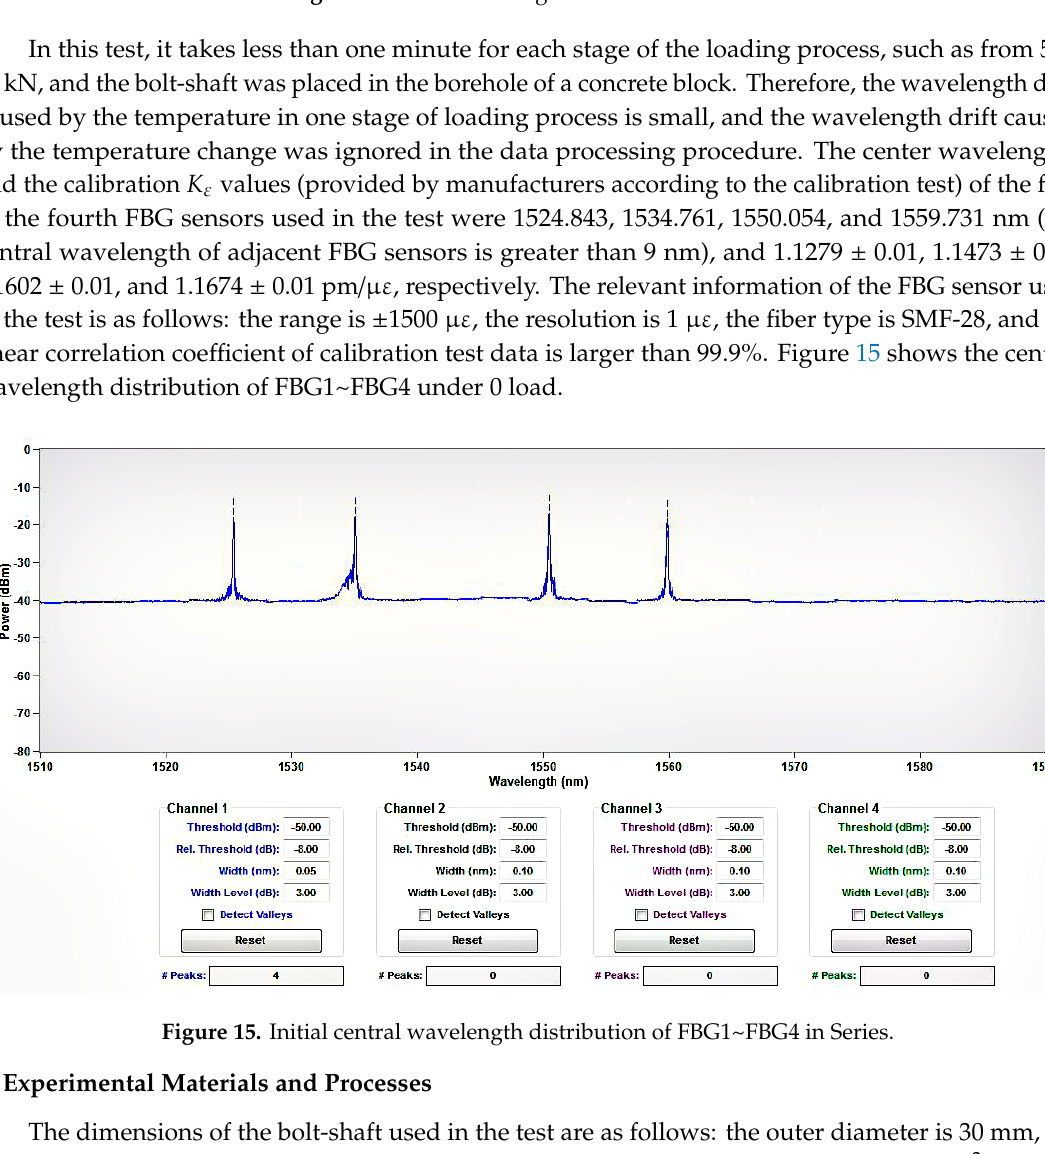
Figure 14. Schematic diagram of rock bolt force.